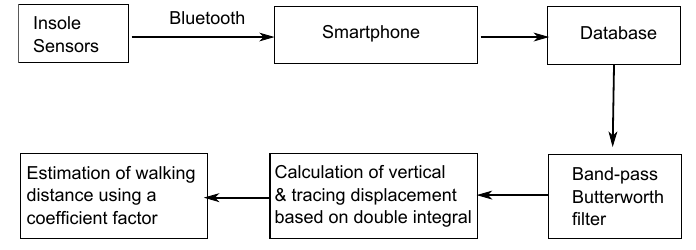
Figure 4. Diagram of data processing in the estimation